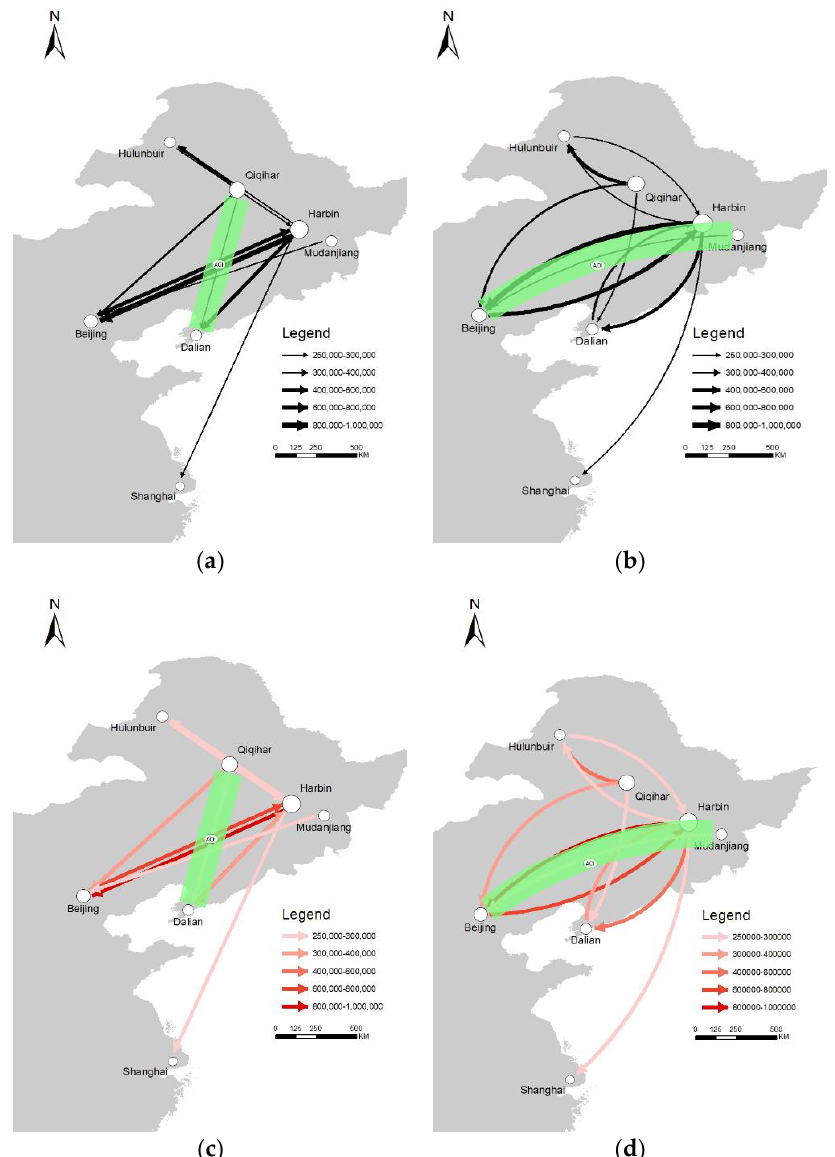
Figure A1. Samples of maps with AOIs. SL = straight line; CV = curve; LT = line thickness; and CG = color gradient. ( a ) SL + LT ; ( b ) CV + LT ; ( c ) SL + CG ; and ( d ) CV + CG